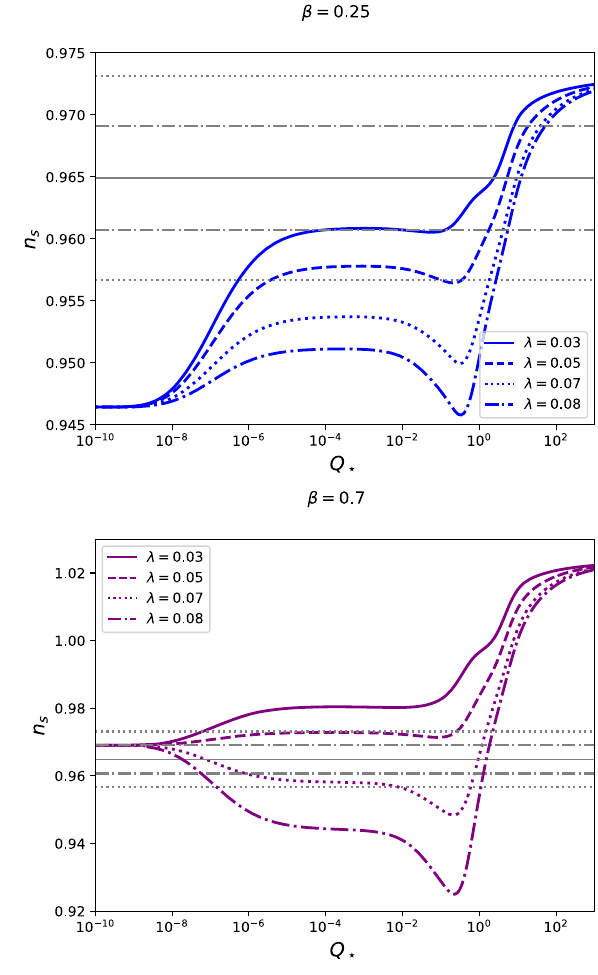
Fig. 2 The spectral index n s as a function of Q (cid:10) , for fixed values of β and λ = 0 . 03 , 0 . 05 , 0 . 07 , 0 . 08. As for the values of β , we have β = 0 . 2 (upper left), β = 0 . 25 (upper right), β = 0 . 5 (lower left) and β = 0 . 7